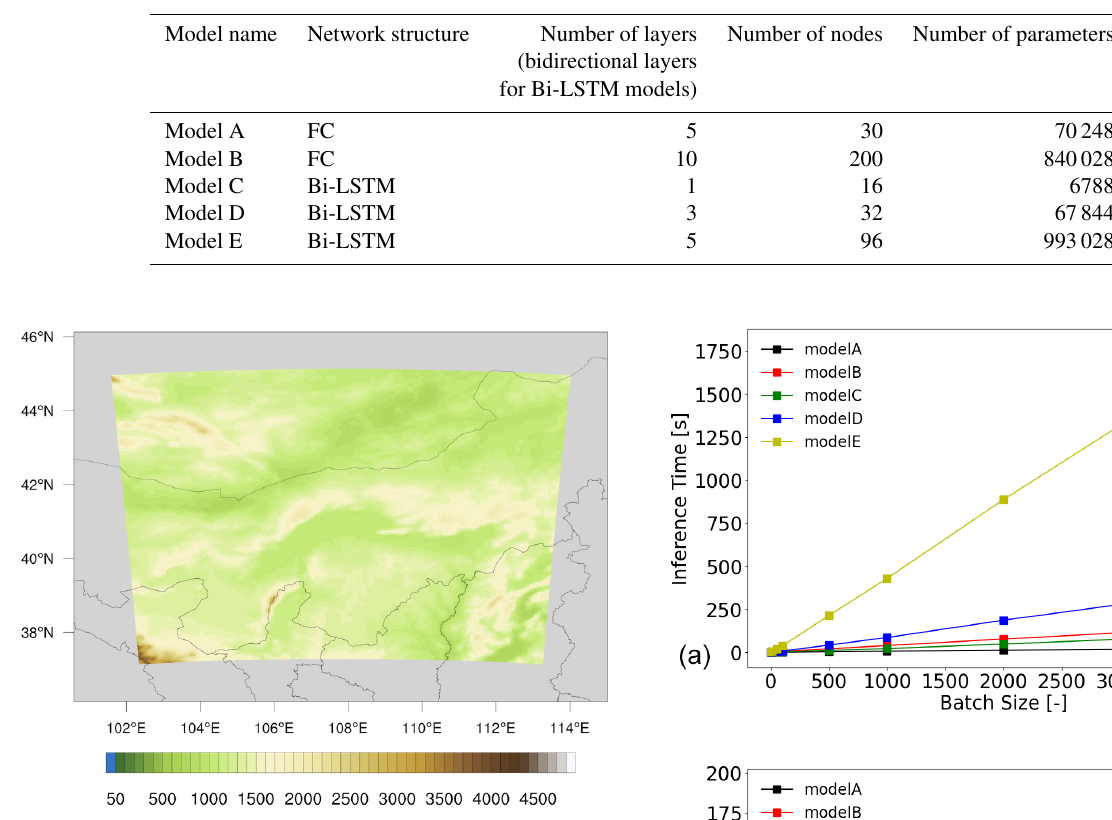
Table 1. Description of different ML models used for emulating radiative transfer calculations, including description of model structures and total number of parameters.